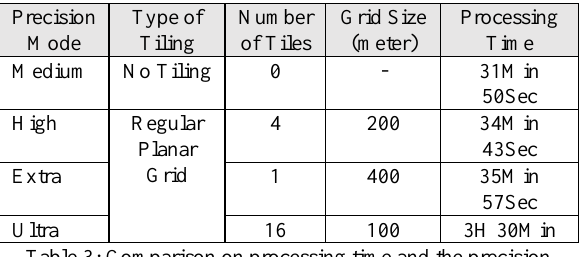
Table 3: Comparison on processing time and the precision mode.